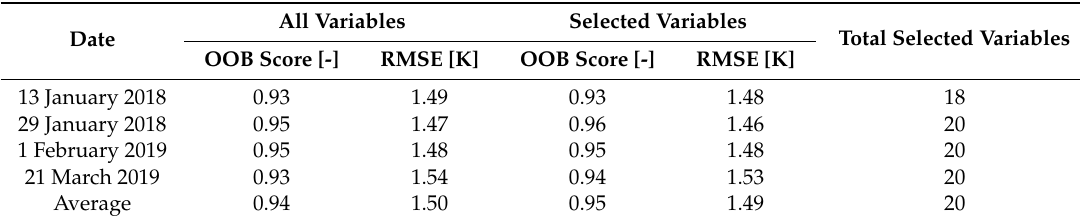
Table 4. Error metrics obtained with all variables and RFECV selected variables.